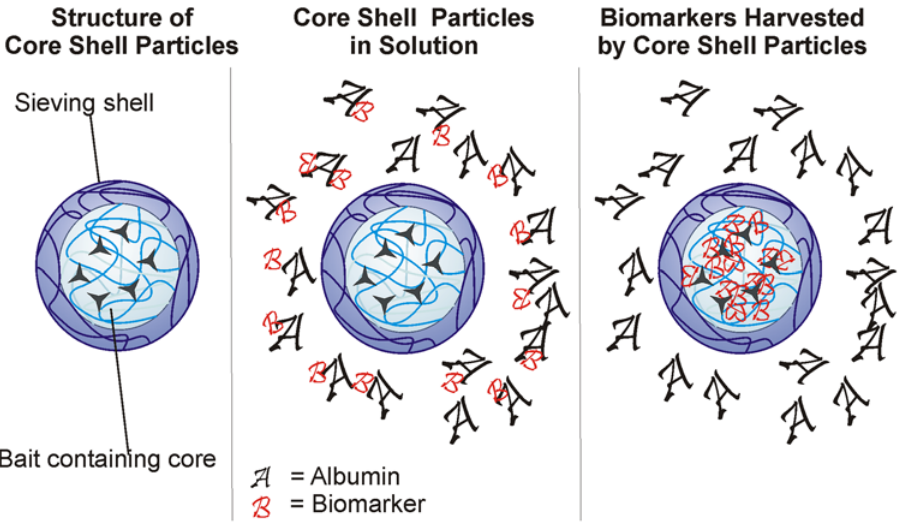
Figure 2. Schematic illustration of core shell particle. The nanoparticle consists of a NIPAm-AAc core that functions as a bait. After adding particles to the protein solution, biomarkers are attracted and entrapped in this bait. A NIPAm shell increases the sieving properties of nanoparticles.